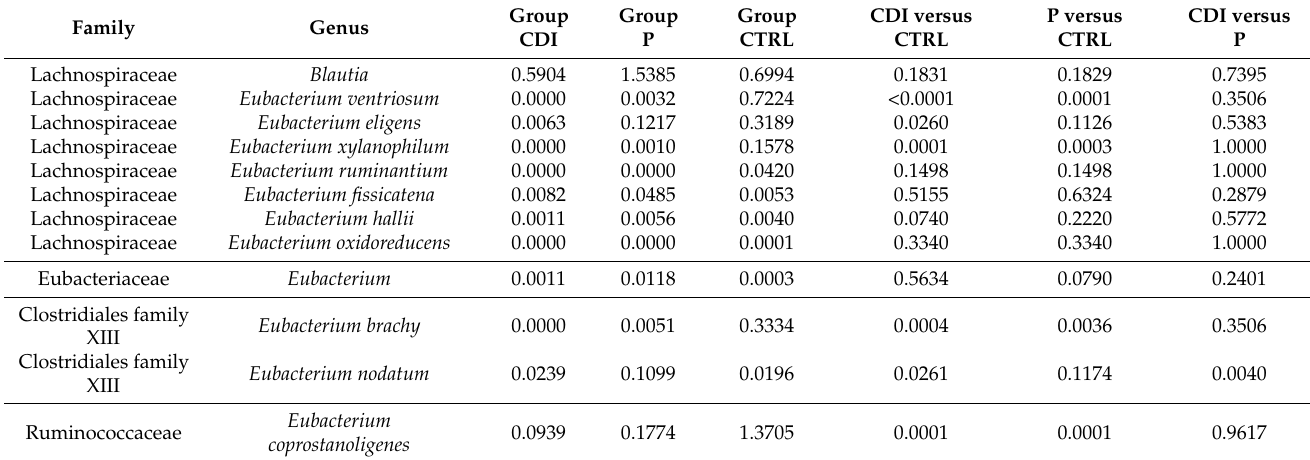
Table 4. Composition analyses of genera of phylum Firmicutes with activity BaiCD in study groups.